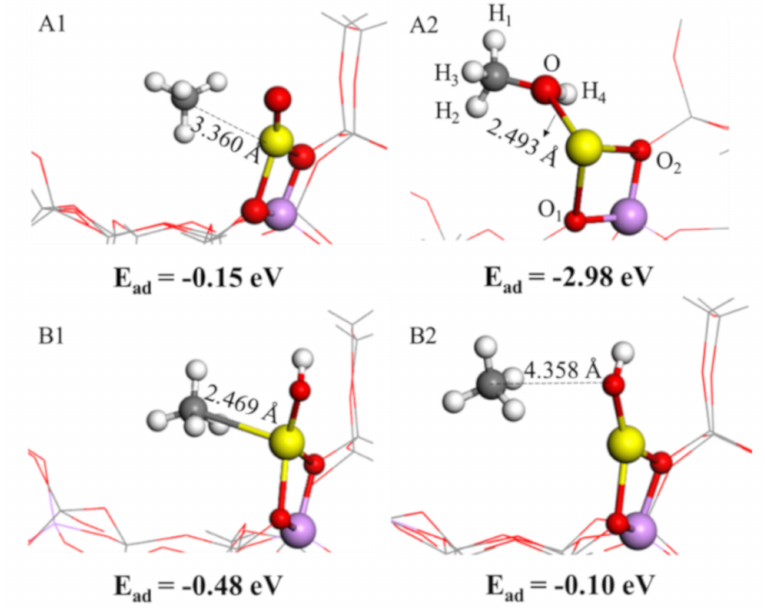
Figure 4. Optimized structures of CH 4 adsorption on ( A1 ) In site of L-model; ( A2 ) O site of L-model; ( B1 ) In site of B-model; ( B2 ) O site of